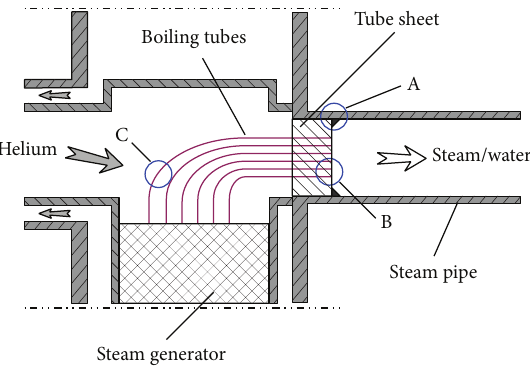
Figure 2: Damageable positions of SG (A: weld of tube sheet with steam pipe; B: joint of boiling tube with tube sheet; C: boiling tubes at steam outlet of SG).